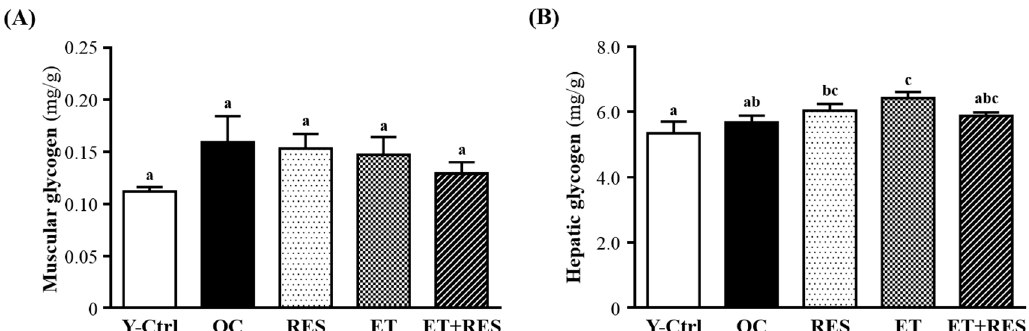
Figure 3. Effect of 4-week resveratrol (RES) supplementation and exercise training (ET) on levels of ( A ) muscular and ( B ) hepatic glycogen. Mice were pretreated with the vehicle, RES, ET, and ET+RES for 28 days. Data are the mean ± SEM. Different letters indicate a significant difference at p < 0.05 according to a one-way ANOVA. Y-Ctrl, a young control group; OC, an older control; RES, a supplementation with RES group; ET, a ET group; ET+RES, a combination of ET and RES supplementation group.